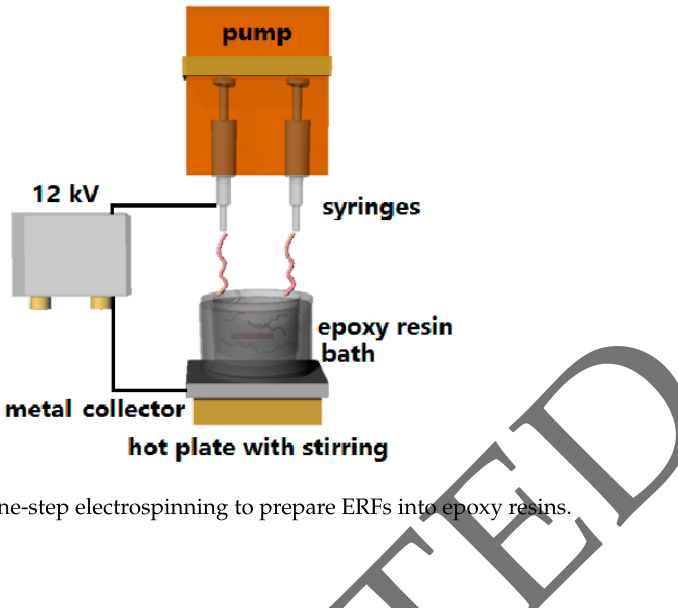
Figure 1. One-step electrospinning to prepare ERFs into epoxy resins.